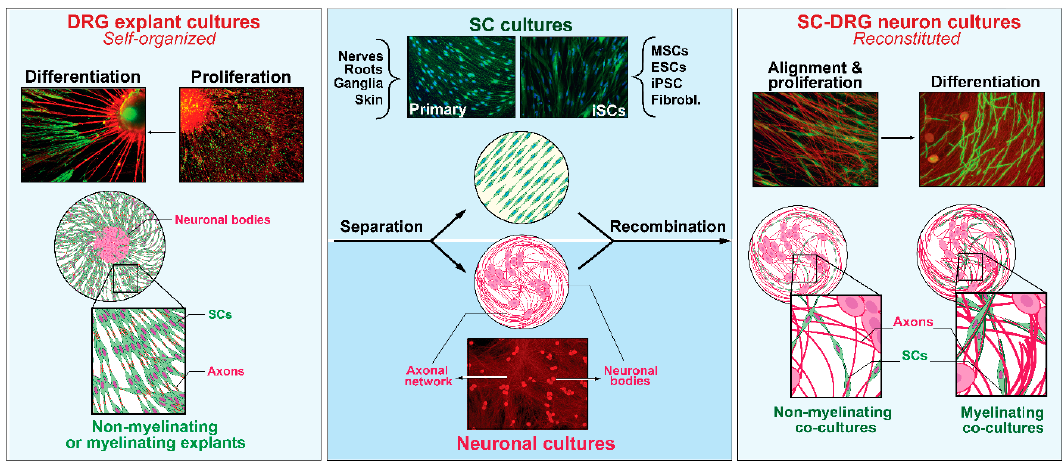
Figure 2. The plasticity of SCs in vitro: deconstruction and reconstitution of neural systems. Explant cultures of sensory (DRG) ganglia ( left ) are complex self-assembled culture systems that rely on the natural regenerative ability of sensory neurons to extend neurites